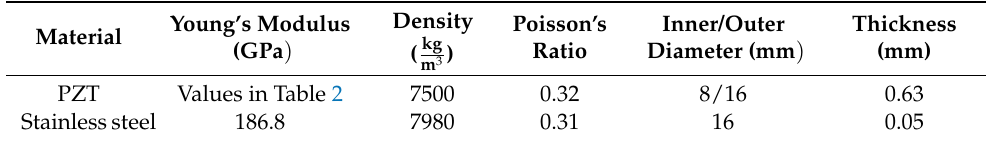
Table 1. Mechanical and geometric parameters of the piezoceramic vibrating mesh atomizer reported in References [6,20].